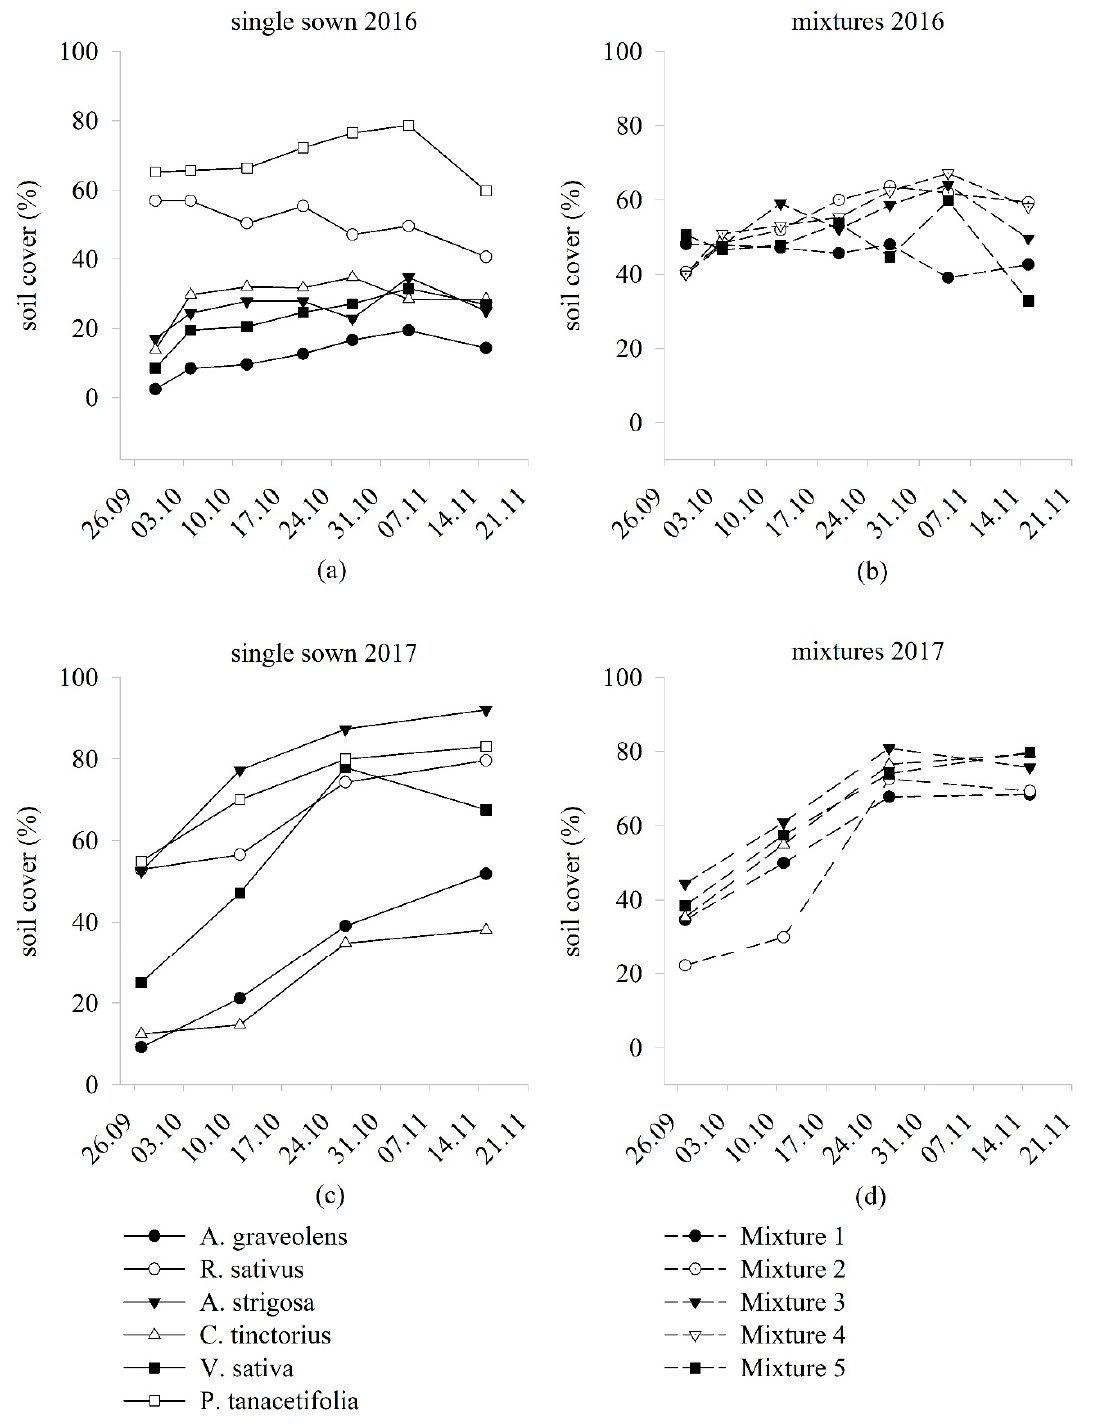
Figure 2. Cover crop soil cover (%) for the six single sown cover crops ( a, c ) and the five mixtures ( b, d ) from the end of September until the end of November in 2016 ( a, b ) and 2017 ( c, d ). Dates in the x - the format axis in the format dd.MM.